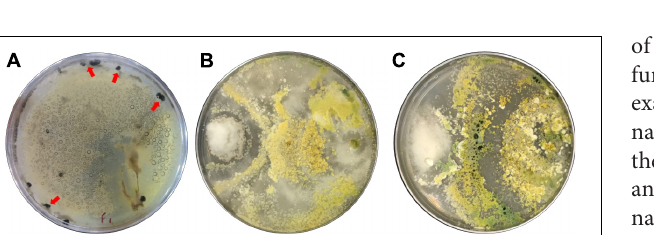
FIGURE 6 | Results of (A) chitinase activity by detection of chitinase positive agar and (B) cellulase activity for T. harzianum fungus encapsulated or not in wet or dry calcium alginate microparticles evaluated for 3 and 5 days of incubation.